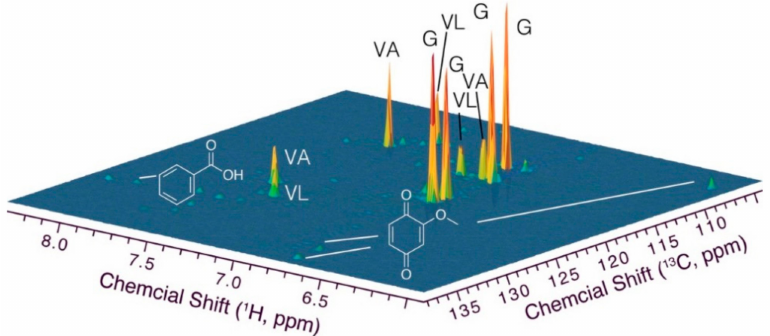
Figure 5. 1 H- 13 C HSQC spectrum of post-reaction mixture displayed showing the main products guaiacol (G), vanillin (VL) and vanillinc acid (VA) alongside a variety of minor byproducts, including benzoic acid and